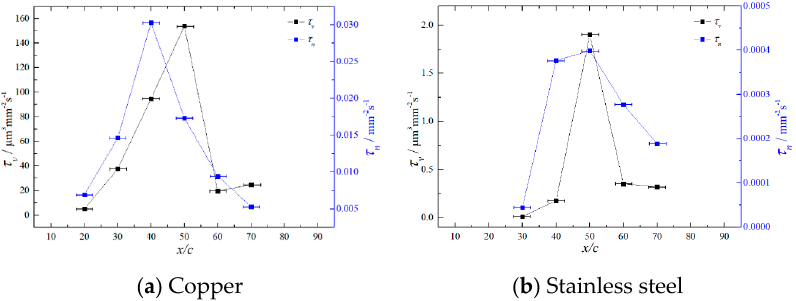
Figure 2. Experimentally measured mean volume deformation rate (black left axis) and mean pitting rate (blue right axis).